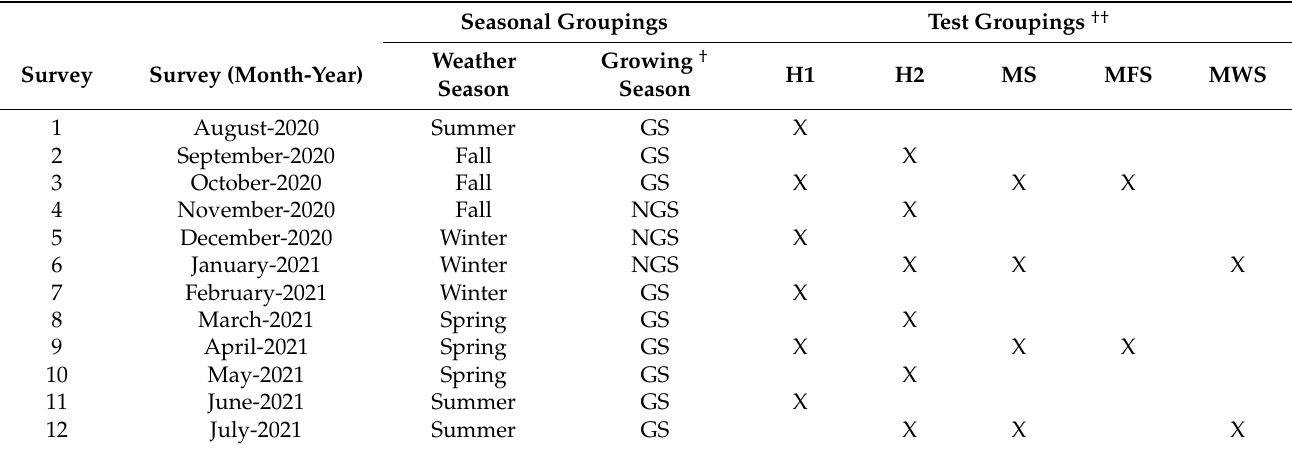
Table 2. Summary of the seasonal (i.e., weather season (summer, fall, winter, and spring) and growing season (growing season and non-growing season)) groupings and the survey groupings compared against all 12 monthly conducted electromagnetic-induction (EMI) apparent electrical conductivity (EC a ) surveys for the homogeneity of variance assessment. The EMI EC a surveys were conducted